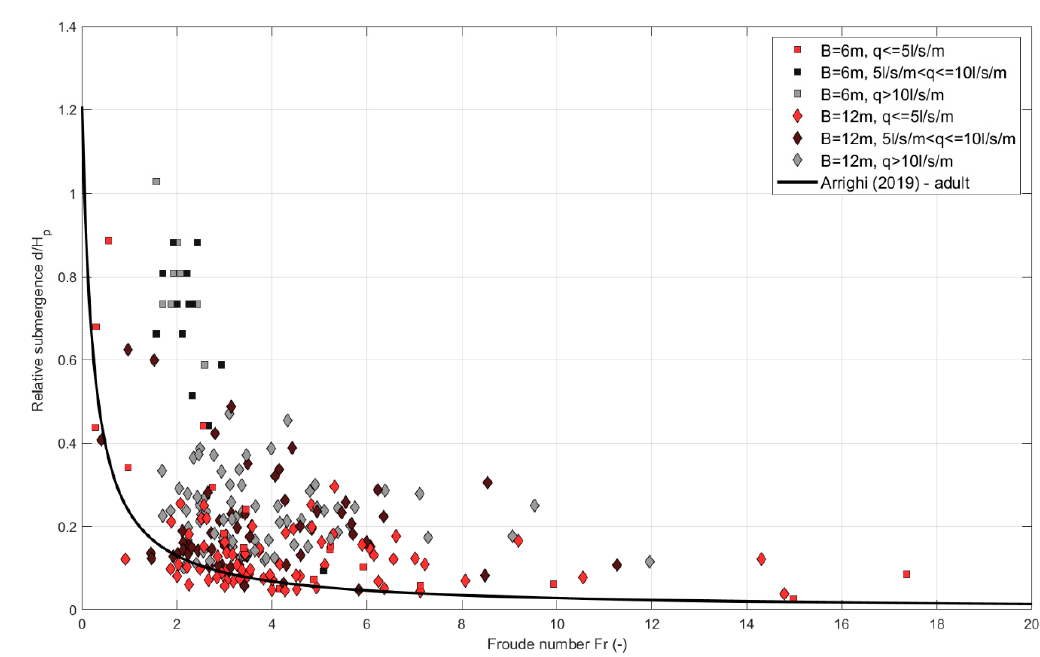
Figure 20. Froude number versus relative submergence, comparison with Arrighi (2017) curve, the discharges are divided for different promenades and measured average discharge.